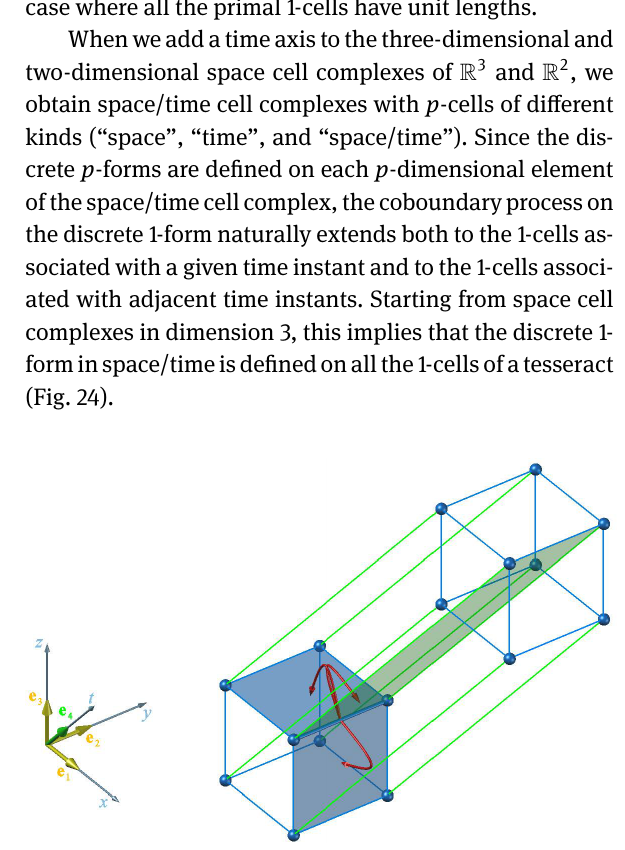
Figure 24: The coboundary process on a discrete 1-form defined for one edge t = t 1 of a